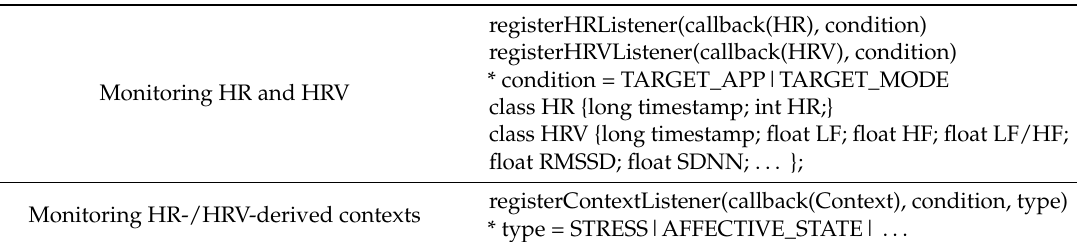
Table 2. Key APIs. HRV, heart rate variability.